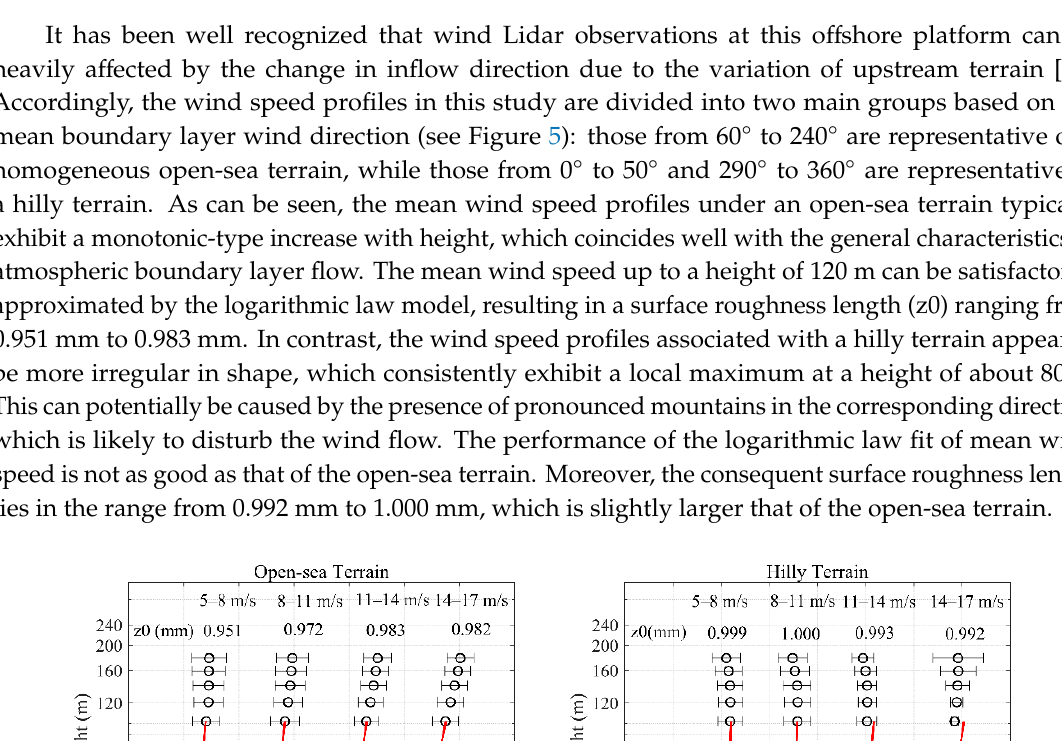
Figure 4. Wind rose plots based on wind Lidar measurements at different heights: ( a ) 23.8 m, ( b ) 101.7 m and ( c ) 178 m.